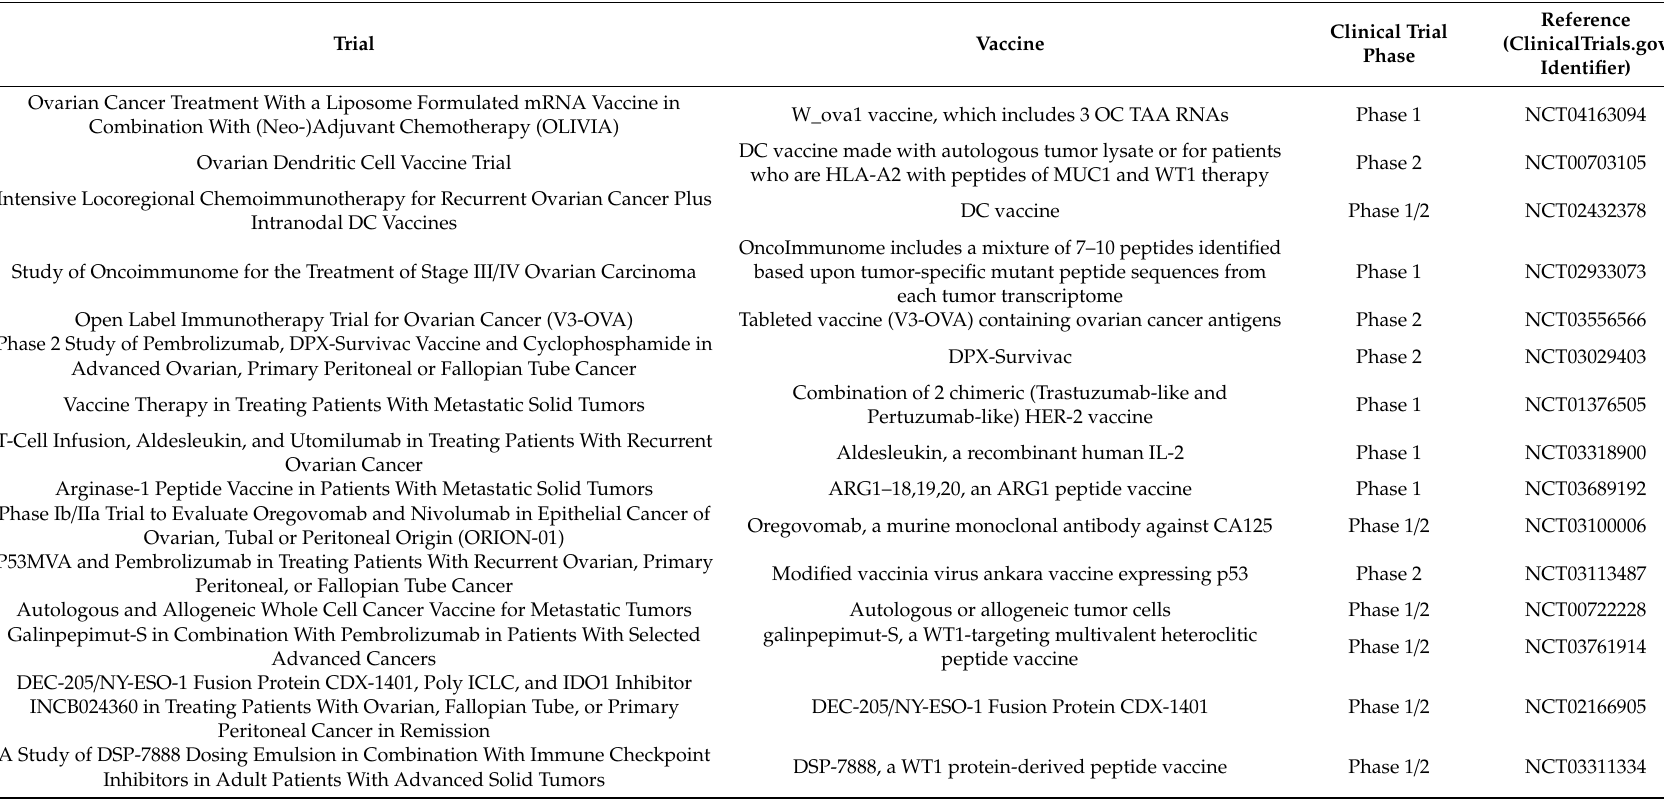
Tables OC: ovarian cancer; RNA: ribonucleic acid; DC: dendritic cell; ARG1: arginase-1; WT1: Wilms